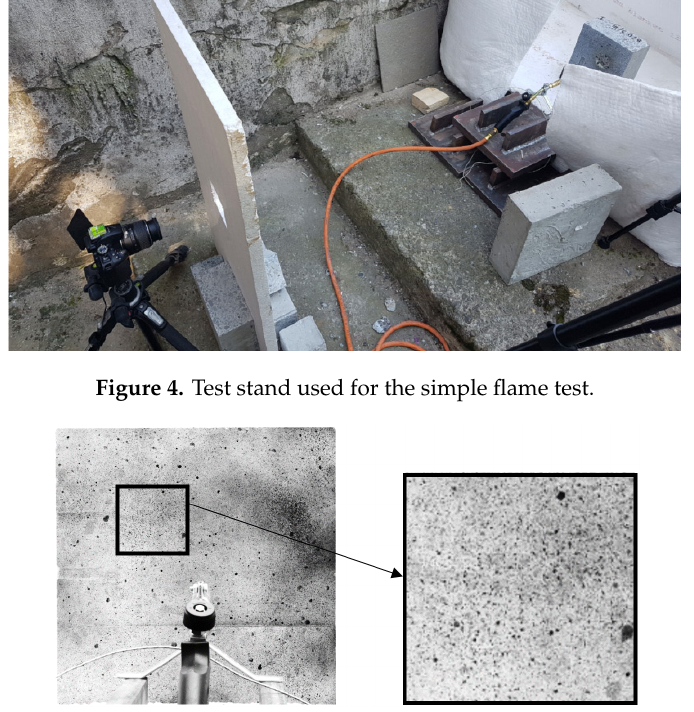
Figure 5. Pattern of randomly distributed black dots to be tracked by digital image correlation (DIC).